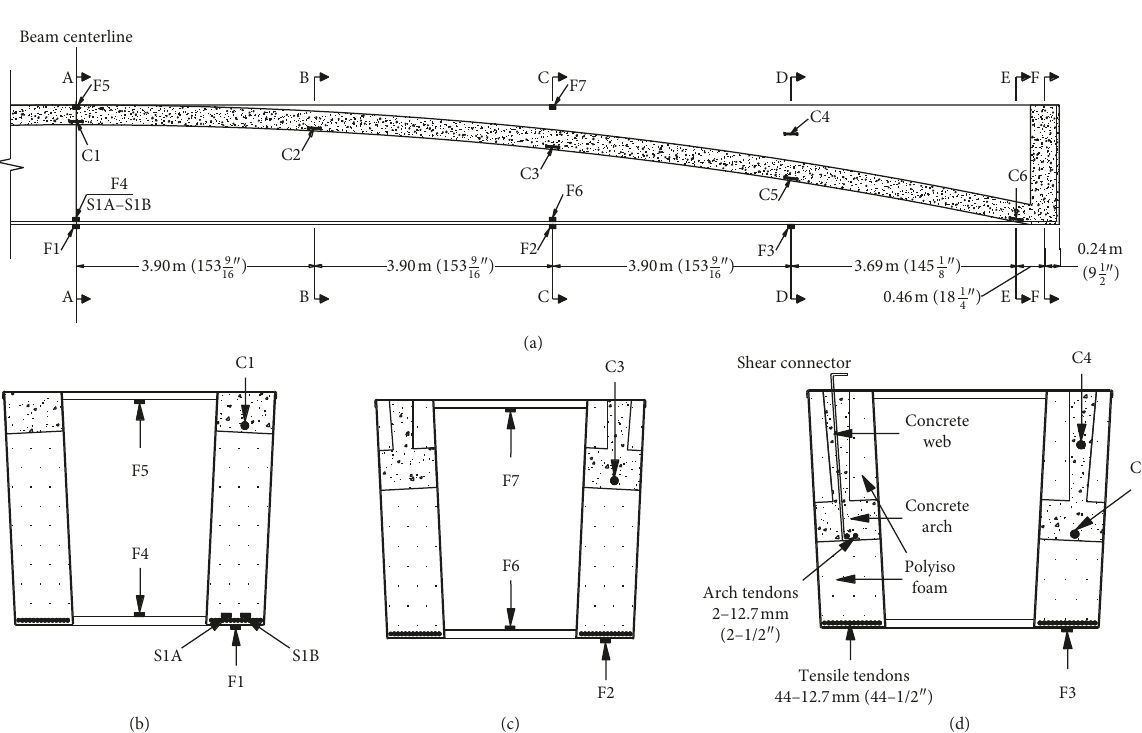
Figure 2: HCB2 instrumentation. (a) HCB2 elevation. (b) Section A-A. (c) Section C-C. (d) Section